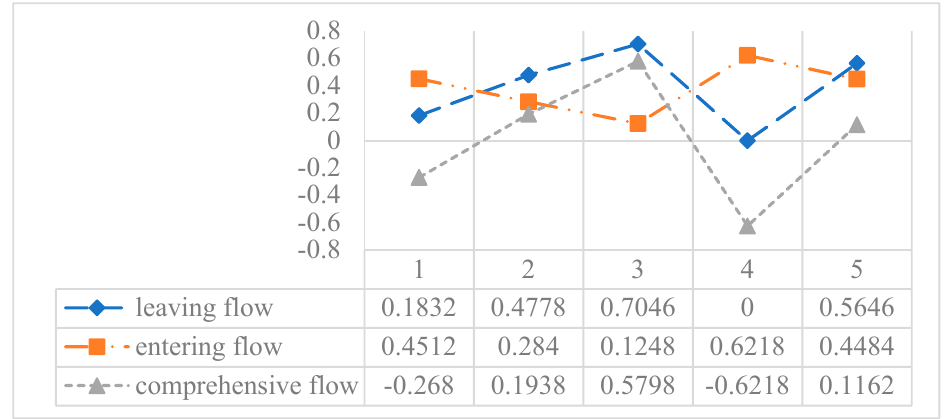
Figure 5. Leaving flow, entering flow and comprehensive flow of hotels in Method 1.